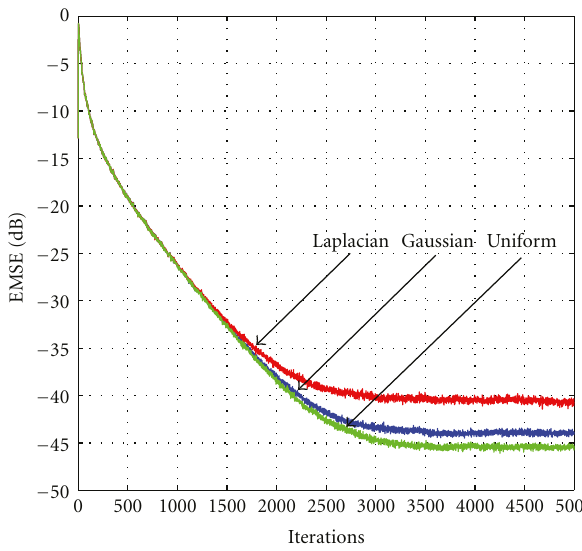
Figure 9: Learning curves of the proposed algorithm in di ff erent noise environments scenarios for α = 0 . 2 and SNR of 20 dB.